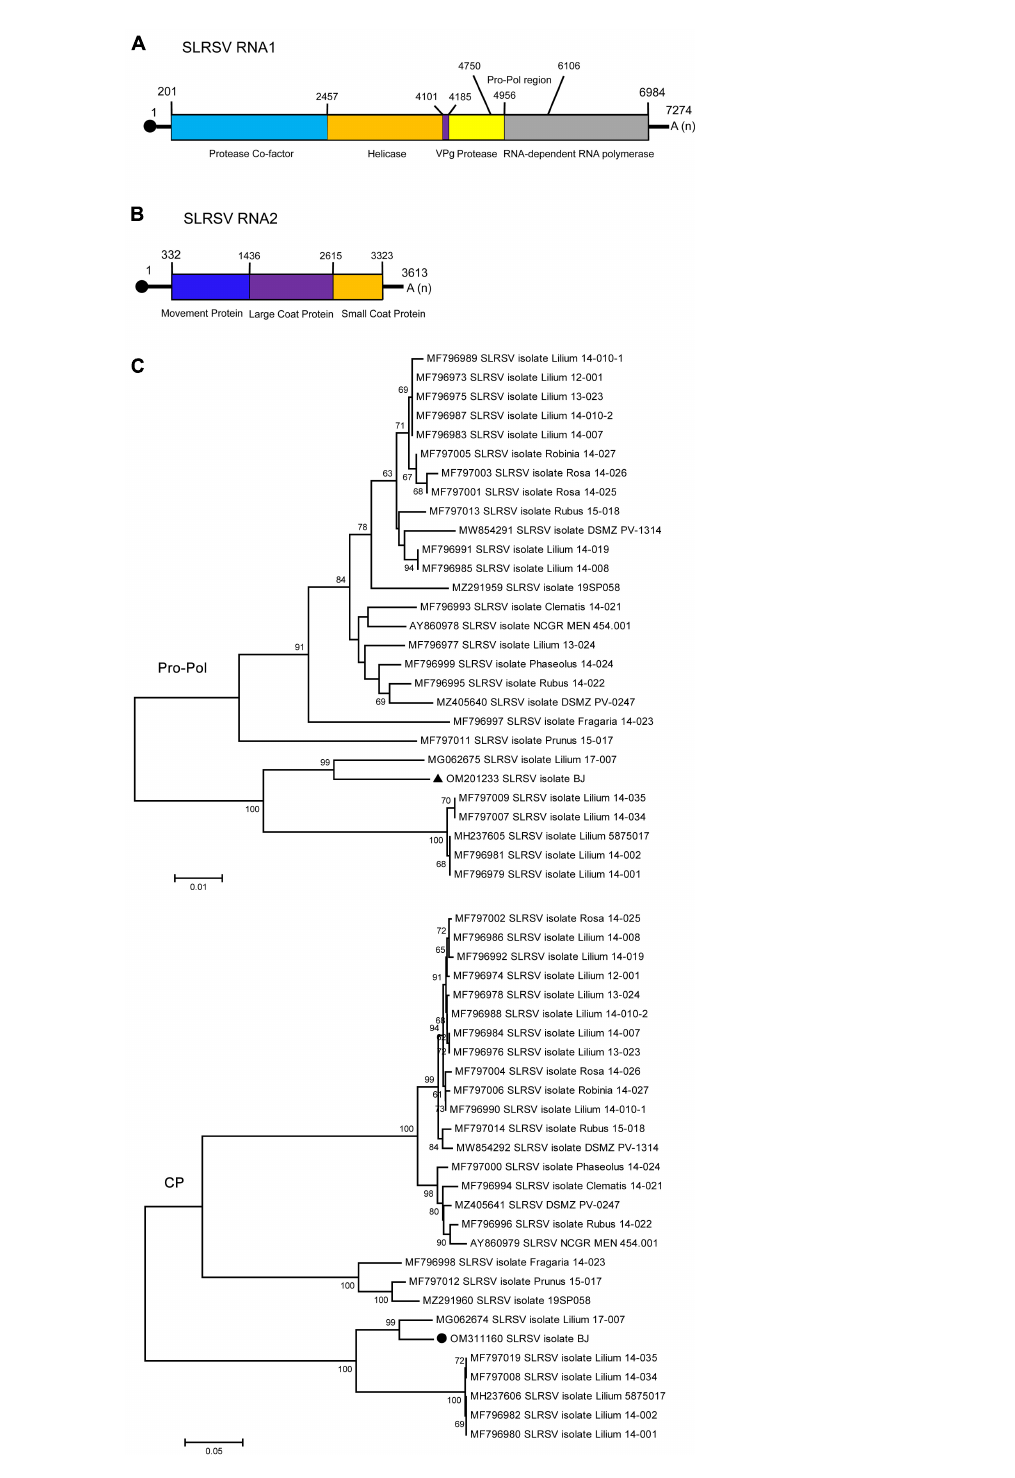
FIGURE3 Schematic representation of the genomic organization of strawberry latent ringspot virus (SLRSV). (A) The nucleotide positions of the protein domain sites of SLRSV RNA1 were listed. The large box represents the polyprotein encoded by SLRSV RNA1, and the small colored boxes represent the protease co-factor (blue), helicase (orange), VPg (purple), protease (yellow), and RNA-dependent RNA polymerase (gray), respectively. The nucleotide position of Pro-Pol region was also listed. (B) The nucleotide positions of the protein domain sites of SLRSV RNA2 were listed. The large box represents the polyprotein encoded by SLRSV RNA2, and the small colored boxes represent the movement protein (blue), large coat protein (purple), and small coat protein (orange), respectively. (C) Phylogenetic analyses of the strawberry latent ringspot virus (SLRSV) based on the conserved Pro-Pol region on RNA1 and CP region on RNA2 of all available complete genome sequences constructed with neighbor-joining (NJ) method with 1,000 bootstrap replicates. Bootstrap values are given by numbers at the relevant nodes in the topology and only bootstrap values of ≥ 50% were shown. RNA1 of SLRSV BJ isolate (OM201233) was indicated with solid black triangle, and RNA2 of SLRSV BJ isolate (OM311160) was indicated with solid black